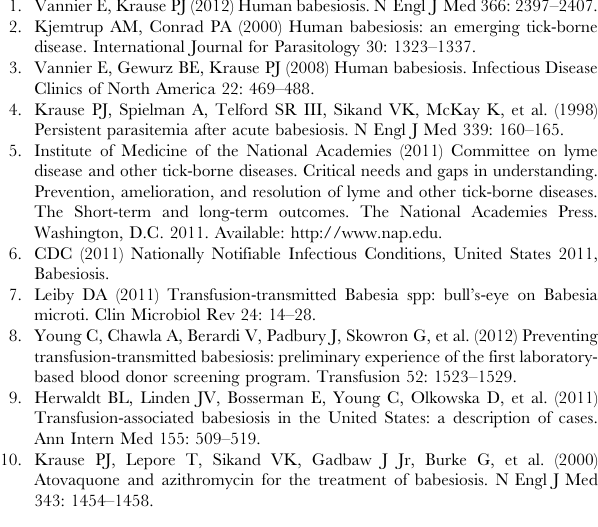
File S1 Figure S1: Multiple alignment of apicoplast genomes from B. microti and other apicomplexan parasites using Mauve. Apicoplast genomes are laid out horizontally with colored blocks representing homologous regions. Gene synteny and BLAST analysis were used to define gene clusters. Figure S2: Major genomic rearrangements revealed by comparing apicoplast genomes of various apicomplexan parasites. Red and blue areas represent conserved syntenic regions in the forward and reverse directions, respectively. Figure S3: Domain structure of ClpC proteins encoded by the apicoplast genome of piroplasmida. The apicoplast genomes of the Babesia bovis T2Bo, Babesia microti R1